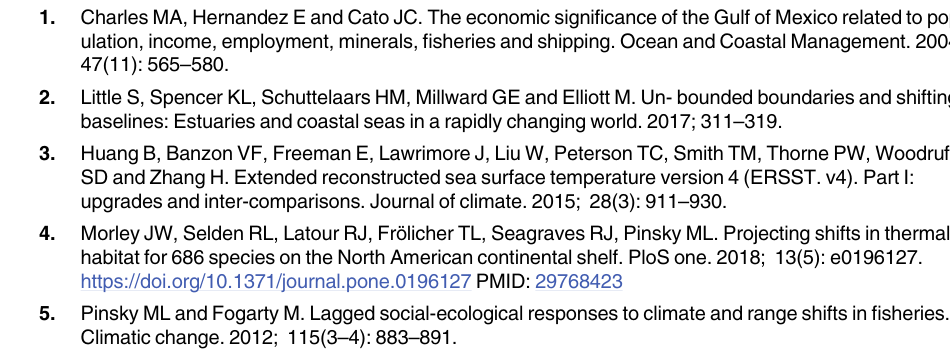
S1 Table. Model bias. (TIF) S1 Fig. DDDBN model predictions. Generated predictions by the DDDBN model. The series marked with stars denote the predictions as opposed to the observed data denoted by circles. 95% confidence intervals report bootstrap prediction’s mean and standard deviation. (TIF) S2 Fig. Pink shrimp and oxygen concentration. (A) Pink shrimp recruitment deviation. (B) Bottom water dissolved oxygen concentration for the Texas coastal shelf in fall.